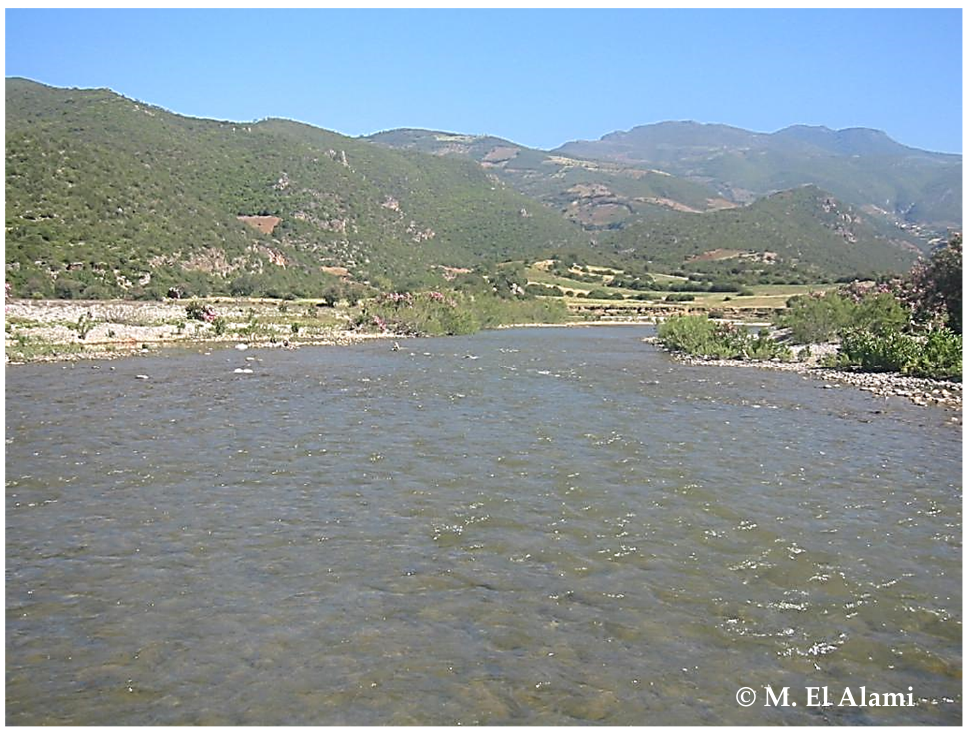
Figure 4. Oued Laou a typical habitat of Baetis gr lutheri. Baetis pavidus Grandi 1949